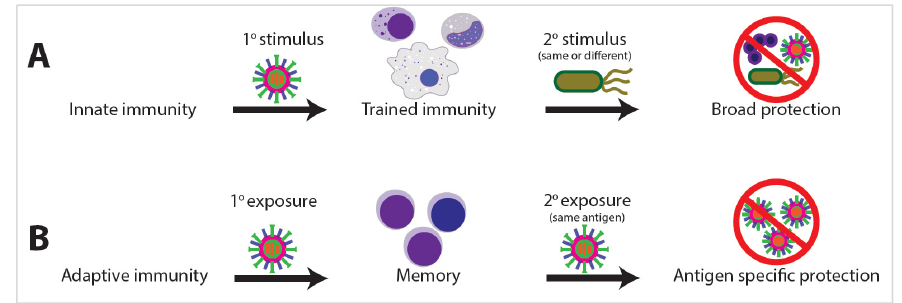
Figure 1. Innate immunity can result in broad immunological protection, whereas adaptive immunity provides antigen-specific protection. ( A ) For innate immunity, trained immunity can provide protection against heterologous stimuli, whereas with adaptive immunity ( B ), memory is elicited with primary exposure to a specific antigen, and then, a secondary exposure and subsequent protection requires exposure with the same antigen.